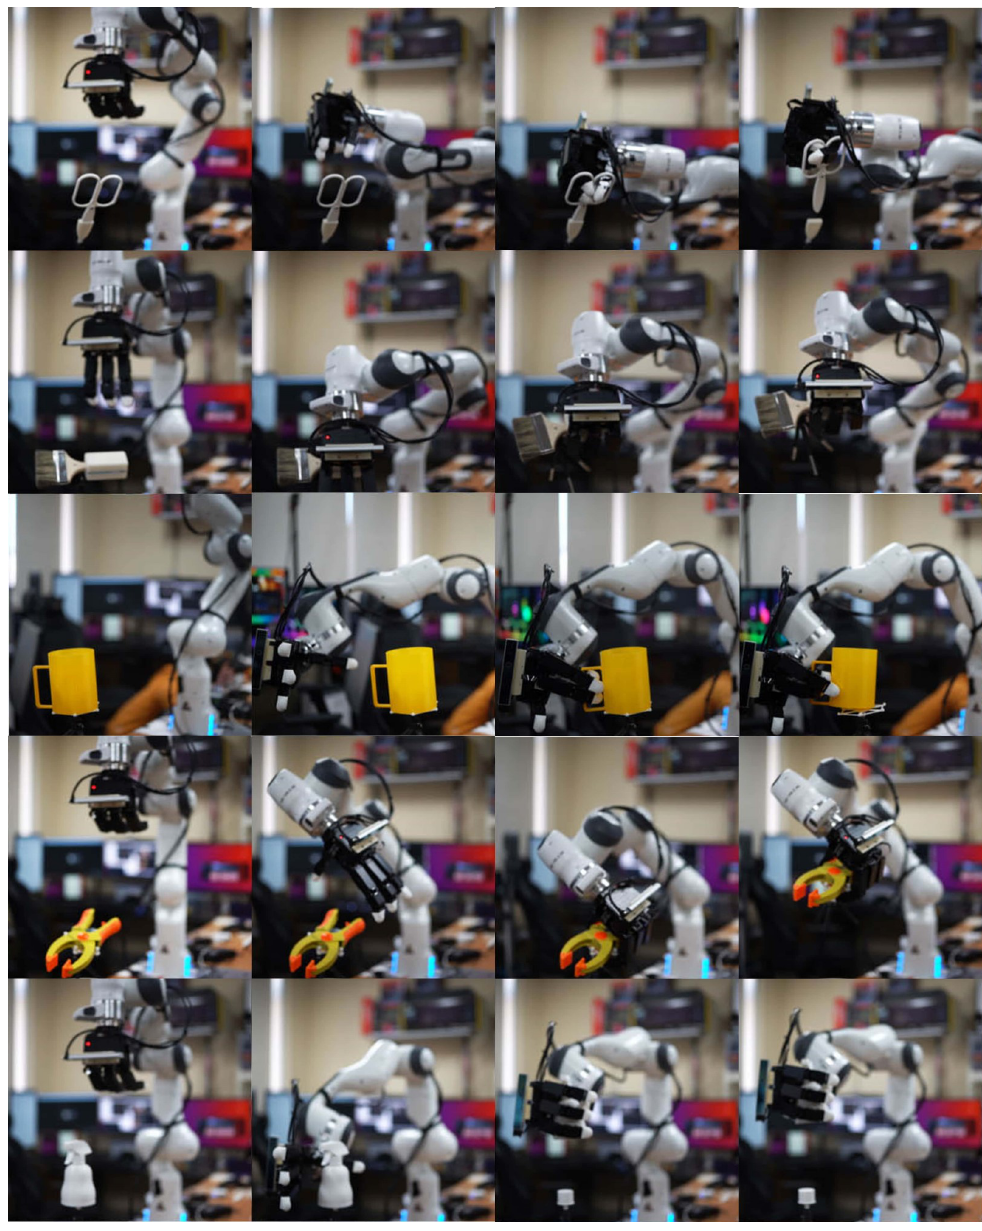
Figure 17. Autonomous grasping of complex-shaped